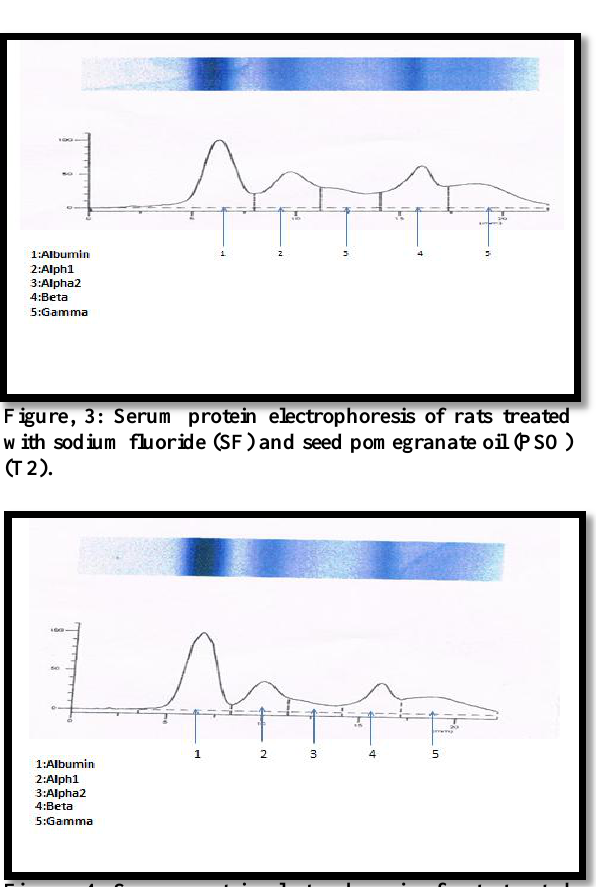
Figure, 4: Serum protein electrophoresis of rats treated with pomegranate seed oil (PSO)